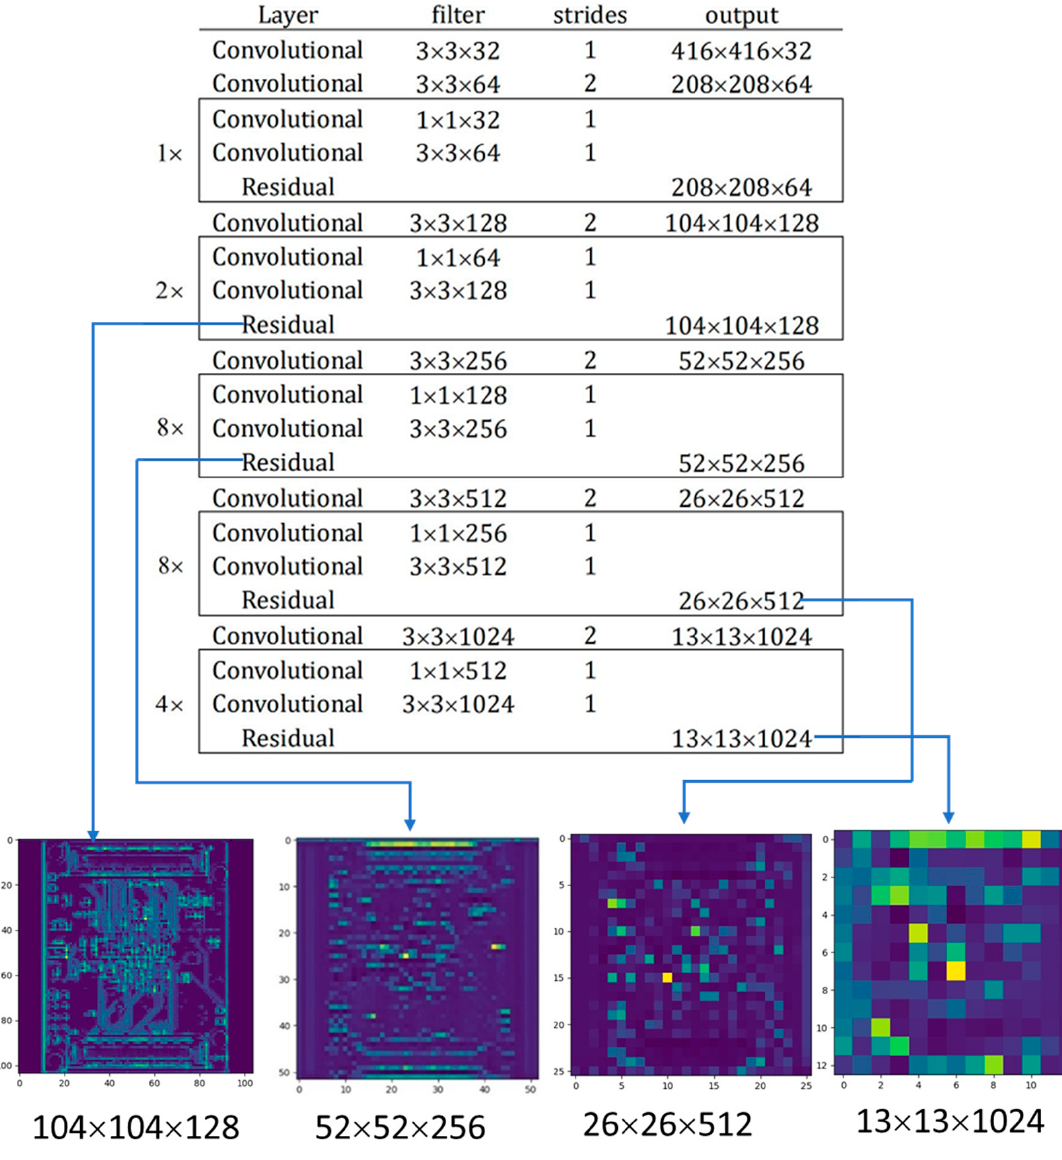
Figure 5. Darknet-53 feature output schematic.